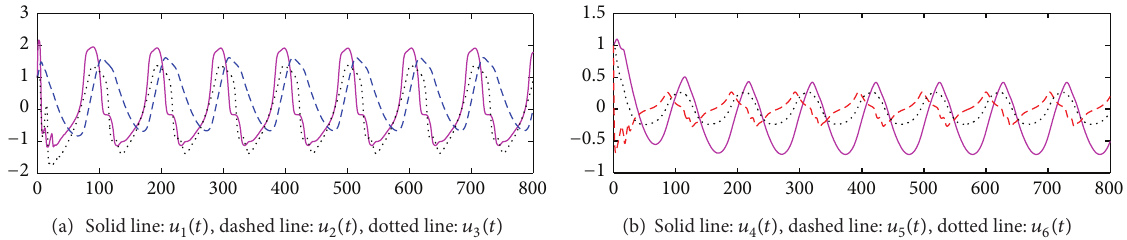
(b) Solid line: 𝑢 4 (𝑡) , dashed line: 𝑢 5 (𝑡) , dotted line: 𝑢 6 (𝑡) Figure 1: Periodic oscillatory behavior, activation function: arctan (𝑢) , and delays: (10, 8, 4).